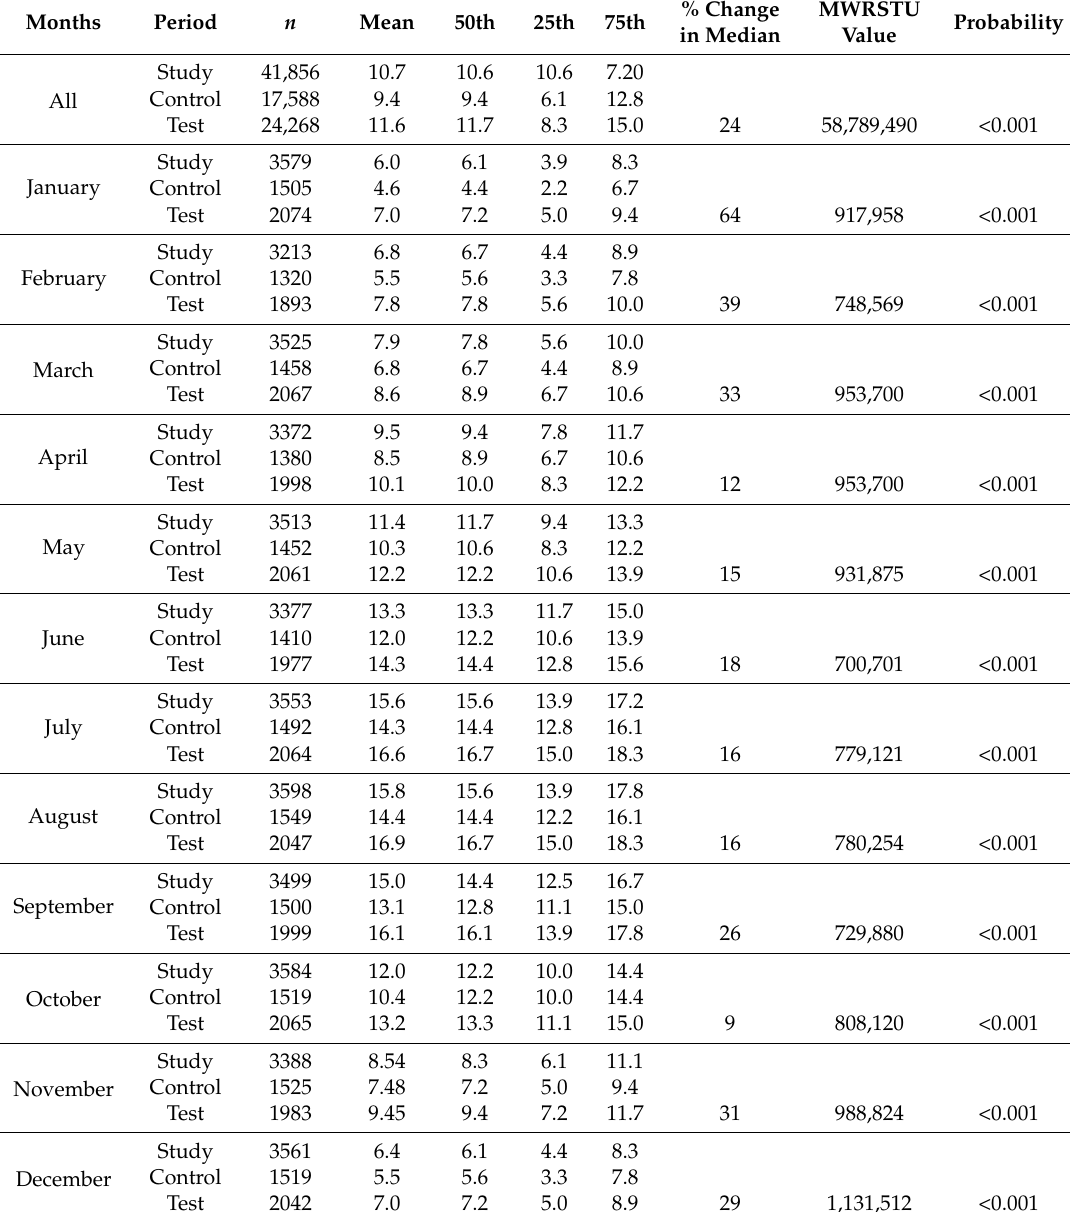
Table 3. Air temperatures in Pasadena between 1886–2016All results are in Degrees CentigradeDaily minimum